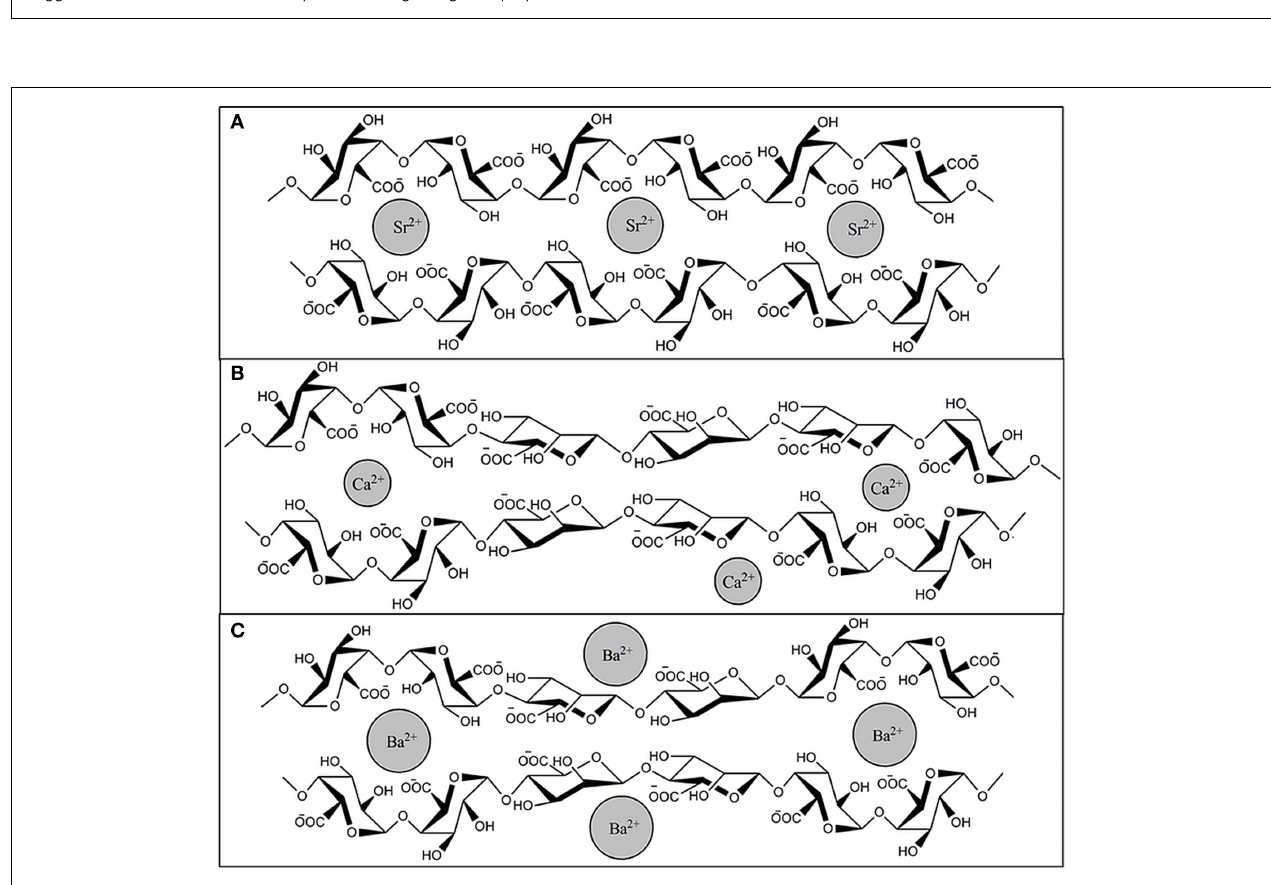
FIGURE 4 | Gelation process of alginate . Alginate dropped from an air droplet generator into a CaCl 2 solution to form a non-homogenous microcapsule in an “egg” formation. Gels are formed by cross-linking of alginate-polymers with calcium ions between G-G and M-G-blocks.